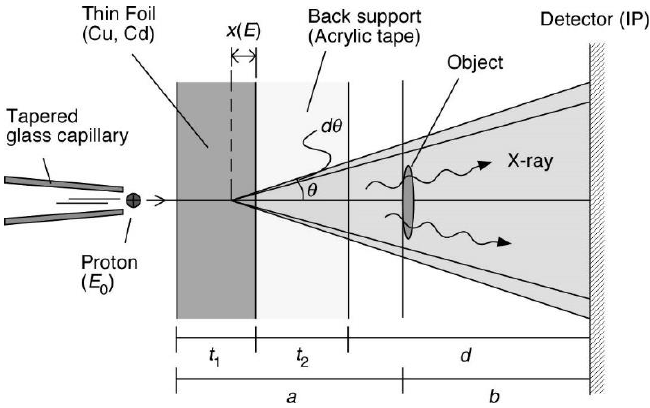
Figure 14. A schematic of quasi-monochromatic X-ray imaging using the glass-capillary-based micro-beam generator (reprinted from [41], Copyright (2008), with permission from Elsevier).